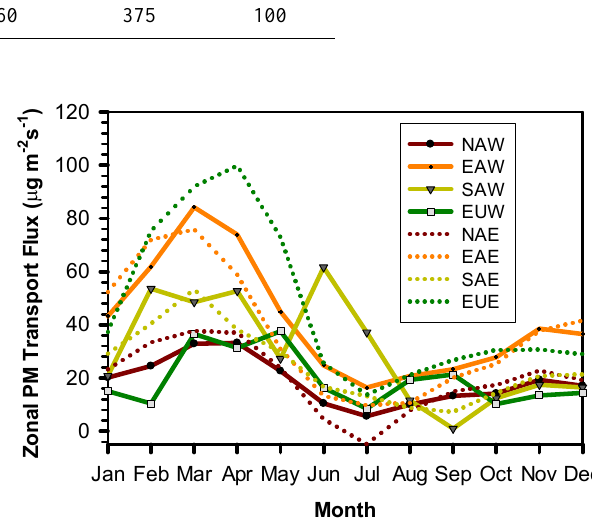
Fig. 2. Monthly variations of zonal aerosol transport fluxes (µgm − 2 s − 1 ) averaged in the vertical sections at the western and eastern borders of HTAP-regions over 1995-2004. NAW (NAE), EAW (EAE), EUW (EUE) and SAW (SAE) respectively stand for the western (eastern) borders of NA, EA, EU and SA